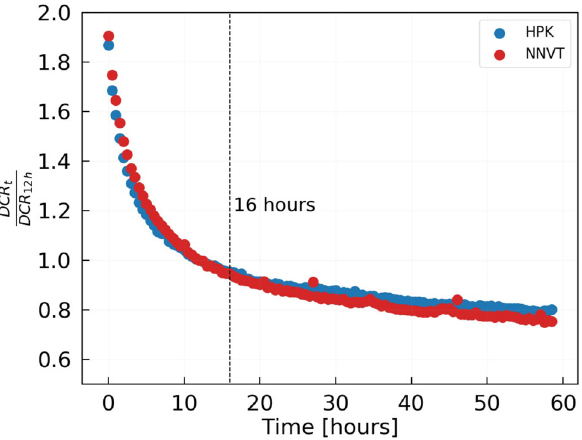
Fig. 21 Measured DCR vs. cooling time for a typical HPK and NNVT PMT. The measured DCR values are normalized to the value taken after 12 h (time after loading the PMT into the container). The indicated time of ∼ 16 h marks the usual time when the final DCR measurement